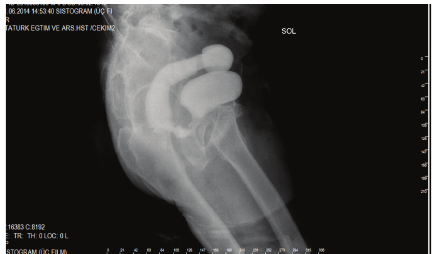
Figure 1: Cystographic presentation of RUF between rectum and urethra is seen.